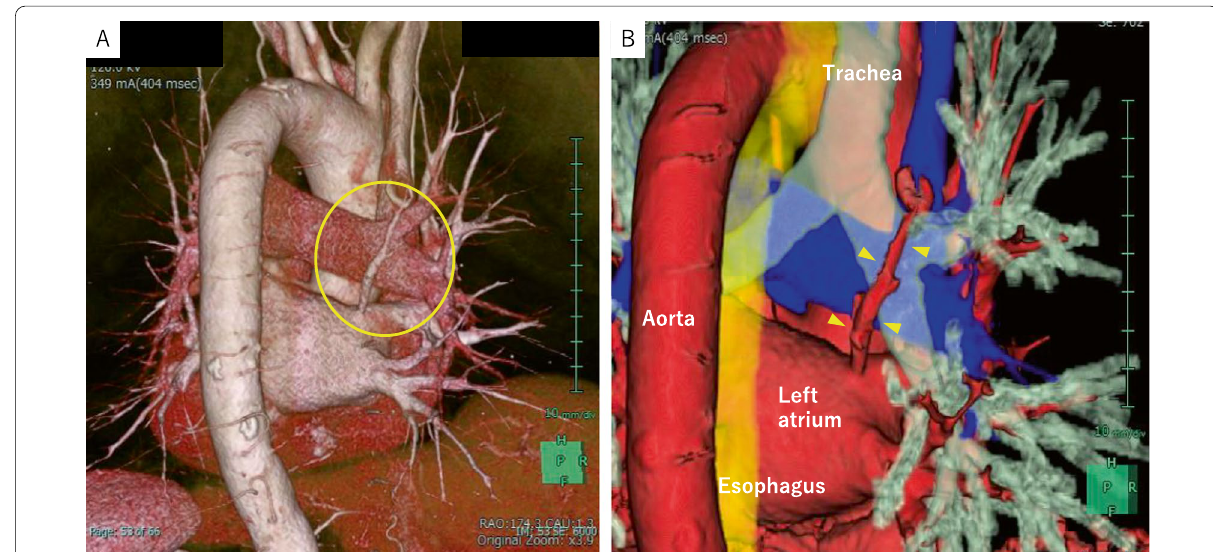
Fig. 2 3D CT imaging. A , B 3D CT was performed preoperatively to confirm the 3D positioning. Arrowhead: The right pulmonary vein passing dorsal to the right main bronchus and flowing directly into the left atrium